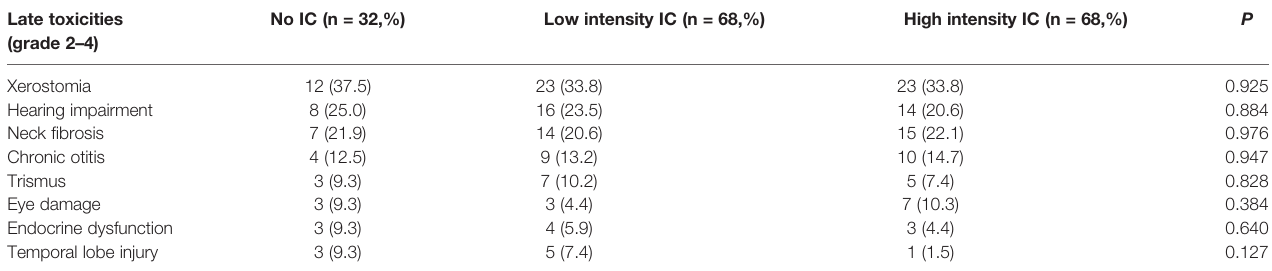
TABLE 5 | Radiotherapy-related grade 2 – 4 late